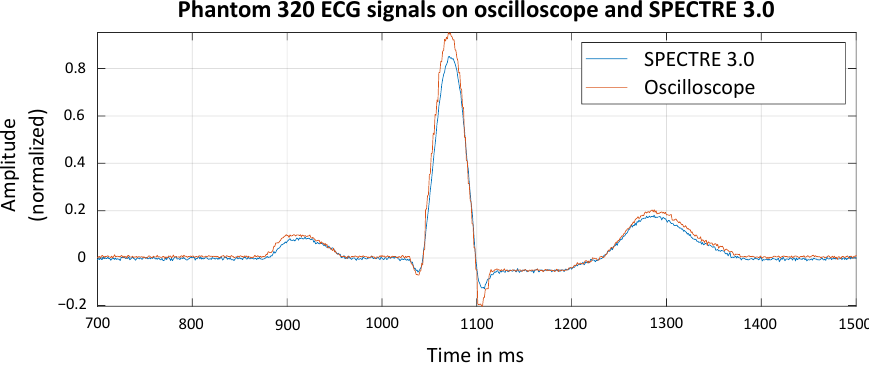
sured both with an oscilloscope and SPECTRE 3.0. The comparison is shown in Figure 8. The excellent agreement between SPECTRE 3.0’s data and the oscilloscope’s reference data confirms that SPECTRE 3.0 is able to obtain valid ECG data from human subjects.